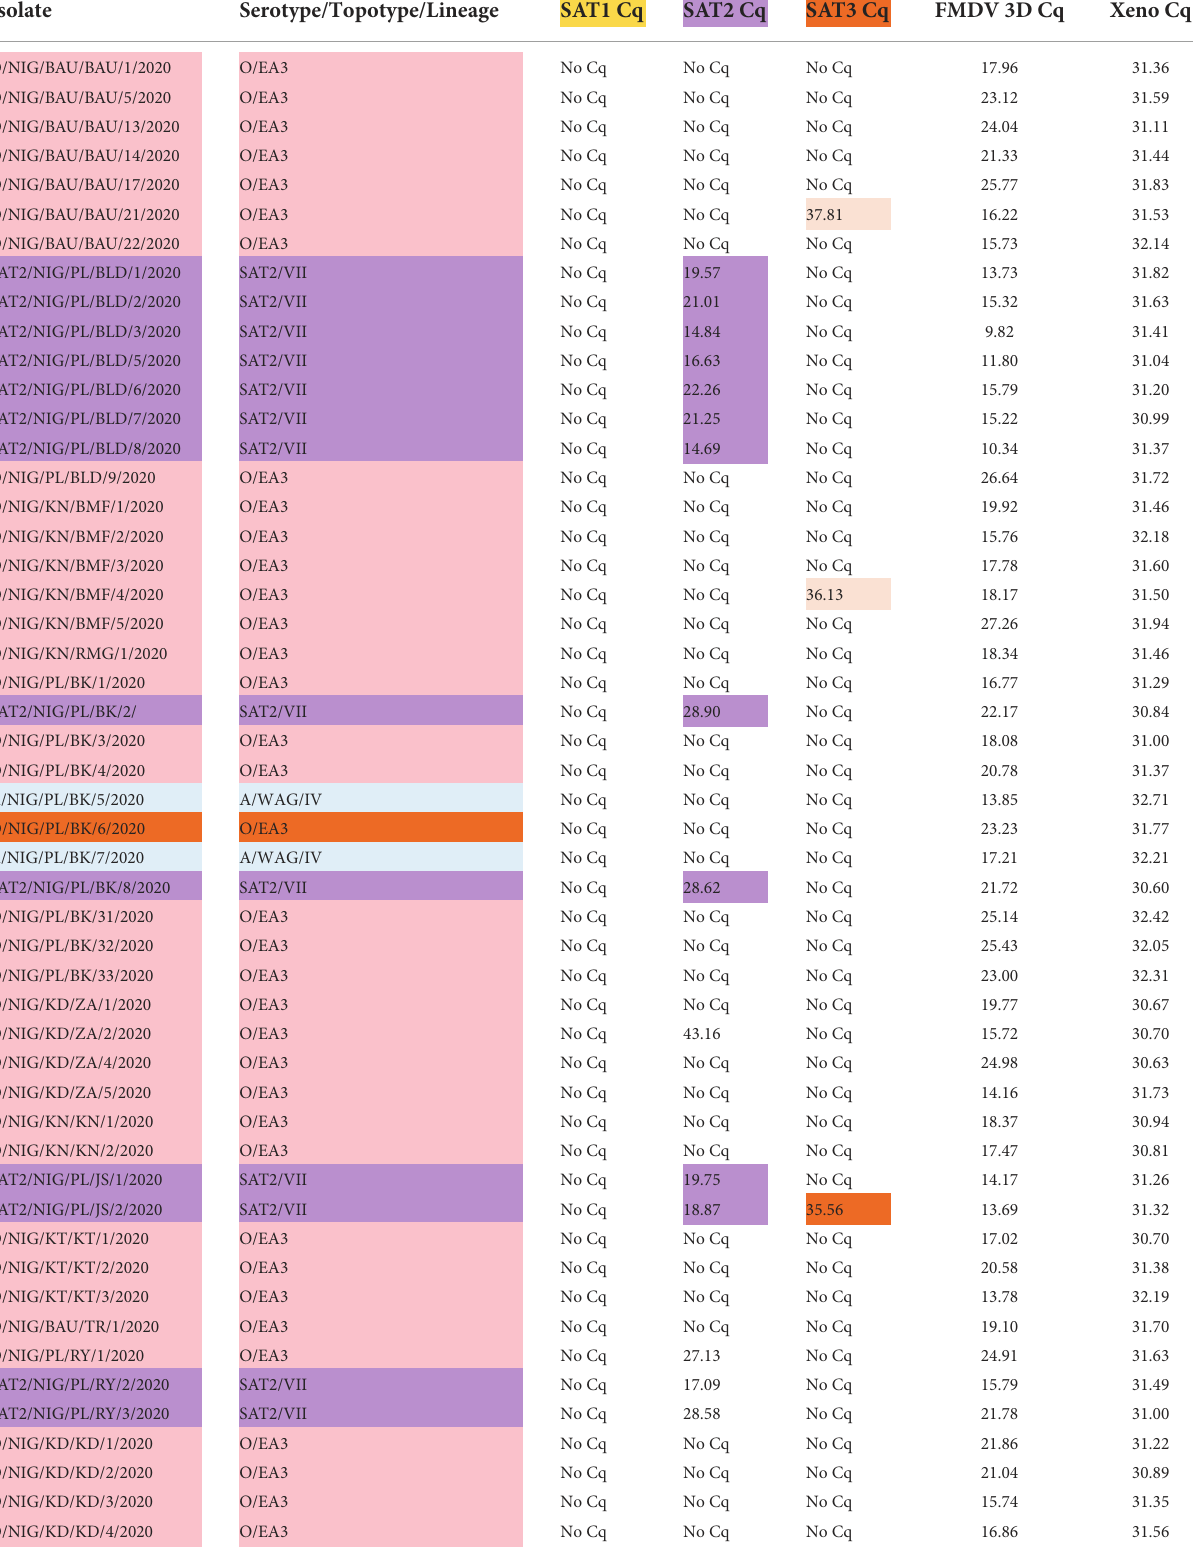
TABLE 5 Detection of FMDV from bovine tissue samples collected from Nigeria using the SAT1, SAT3 and SAT2 topotype VII rRT-PCR assays.